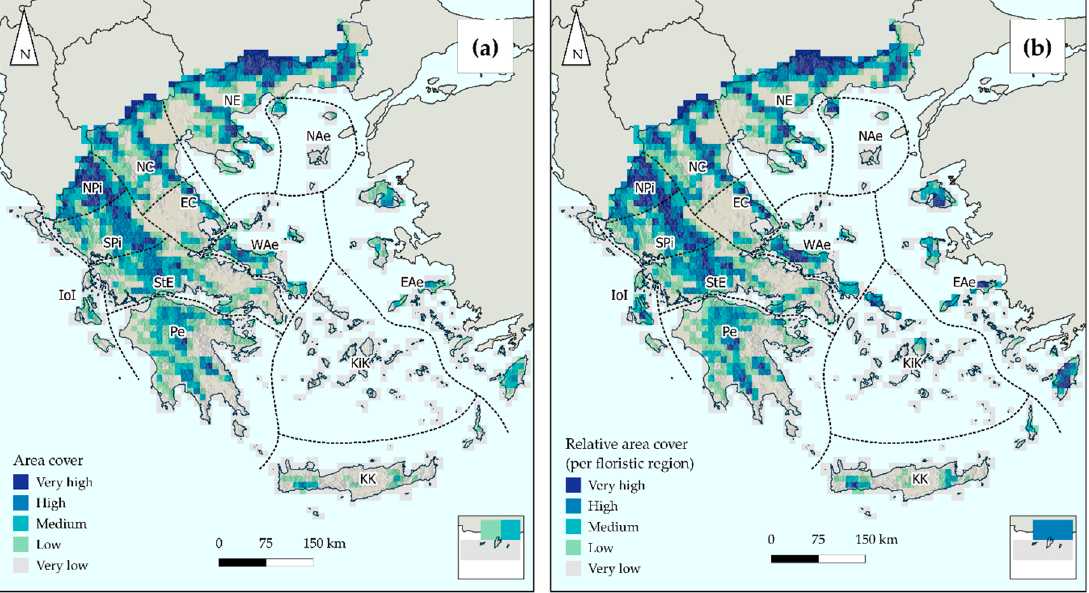
reference grid level: ( a ) Ecosystem extent expressed as the total area of woodland and forest per cell;